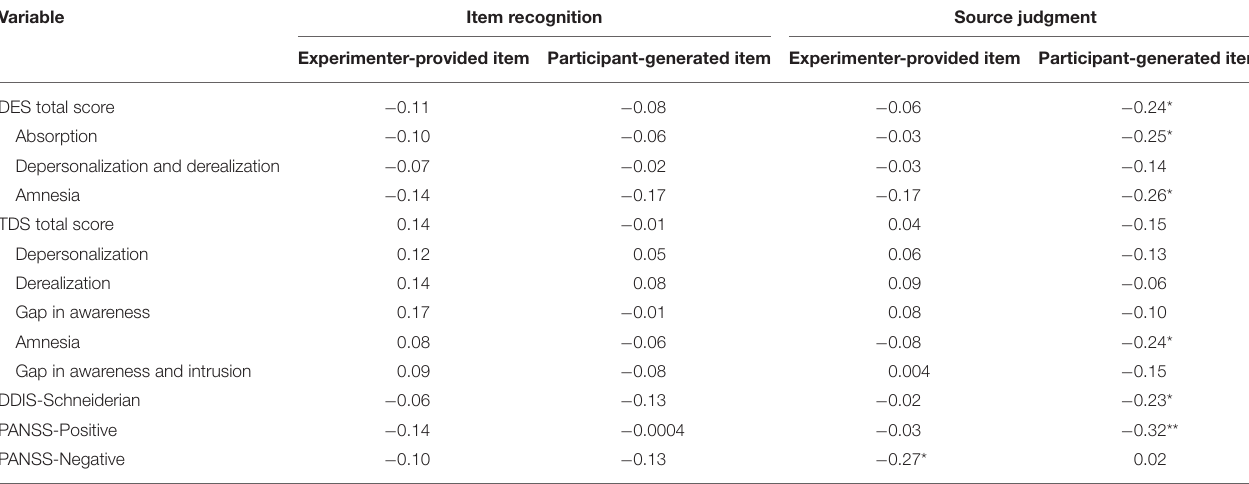
TABLE 3 | Correlation coefficients among dissociation, psychosis, and self- vs.-other source monitoring performance.